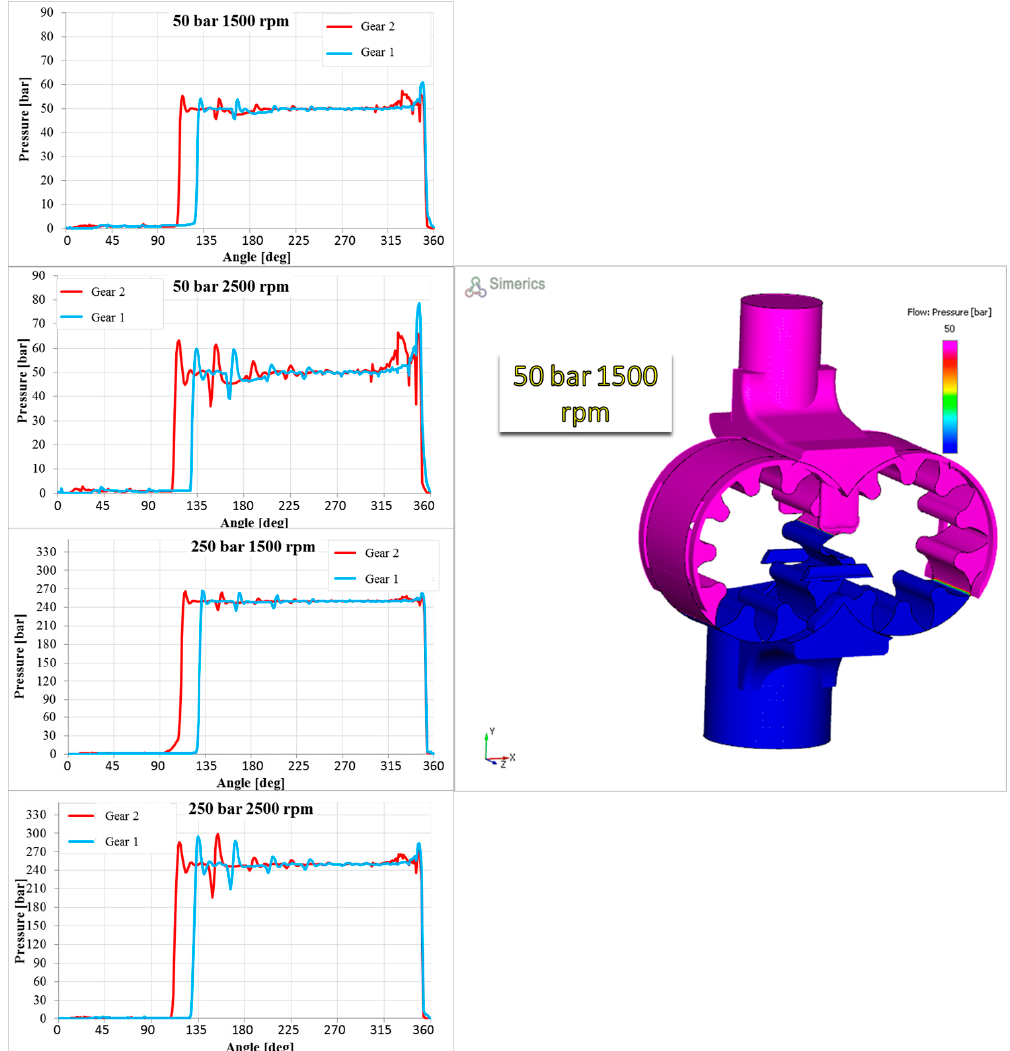
Figure 15. Pressure evolutions for two pressure levels at T oil of 50 °C. As expected, when the chamber is connected to the delivery port, it has an oscillating pressure around the delivery value (in this case 50 and 250 bar). The pressure is smoother around the mean value with a lower pump speed (1500 rpm). At 2500 rpm instead the oscillations around the mean value are high for both delivery pressures. The pressure spikes inside the chambers, at the higher delivery pressure level, are clear for both gears’ fluid volumes. Those investigations, especially the evaluation of the spikes values, are really important for engineers to design or optimize a pump. 0–3.5 bar and reducing the angle-axis to the only the degrees of connection with the pump suction side. the suction port. These results are shown in Figure 16, providing a preliminary investigation of the cavitation phenomena. Cavitation, however, it analyzed in depth in Section